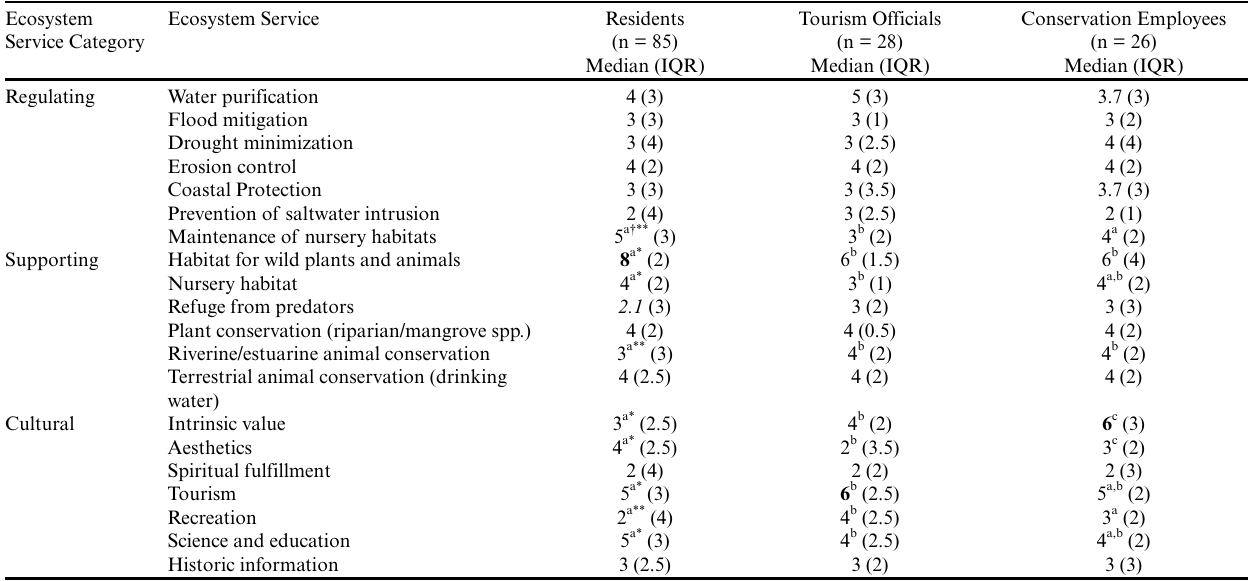
Table 2 . Relative importance of regulating, supporting, and cultural ecosystem services provided by the Wami River and Estuary as perceived by 85 local residents, 28 tourism operators, and 26 conservation employees. The survey respondents distributed 25 marbles among 7 regulation ES (expected value = 3.6), 6 supporting ES (expected value = 4.2), and 7 cultural ES (expected value = 3.6). The values in the table are median (interquartile range). Those in bold and italics denote values 50% higher and lower, respectively, than the expected